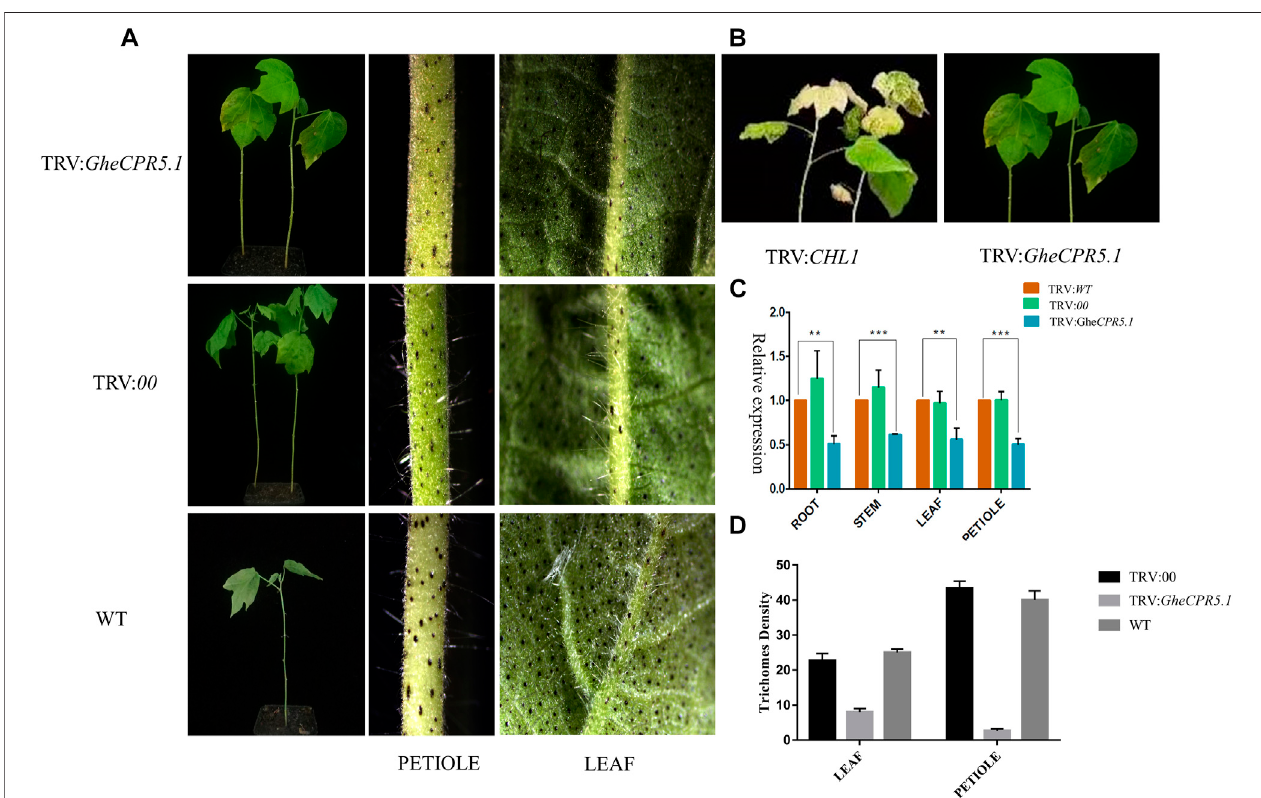
FIGURE 10 | Virus induced gene silencing to elucidate the role of GheCPR5.1 in trichome development and elongation. (A)- Visual images of trichomes after gene silencing. (B)- The blenching phenotypes were observed on TRV: GheCPR5.1 plants. (C)- Relative expression level of GheCPR5.1 in root stem and leaves of silences plants. (D)- Trichome density in the leaves and petioles after GheCPR5.1 silencing in